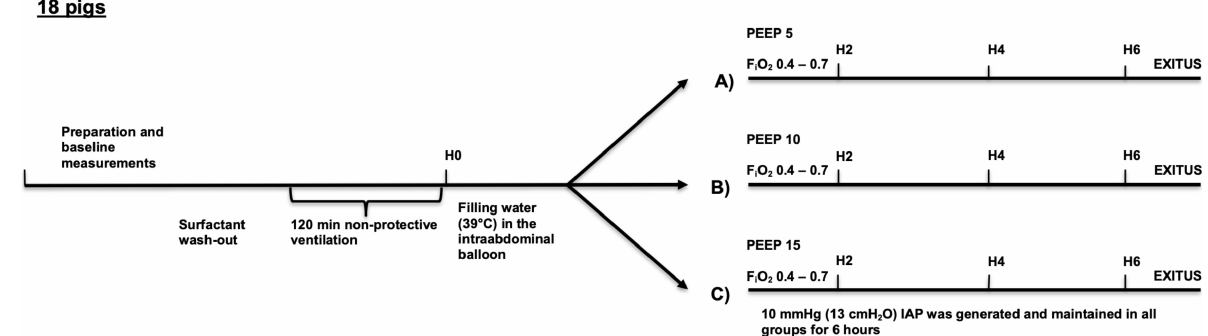
Figure 1. Experimental timeline. H0, H2, H4, H6—hours after lung injury (wash out and injurious ventilation), PEEP— positive end expiratory pressure, FiO 2 —oxygen fraction, IAP—intra-abdominal pressure, ( A )—group A, ( B )—group B, ( C )—group